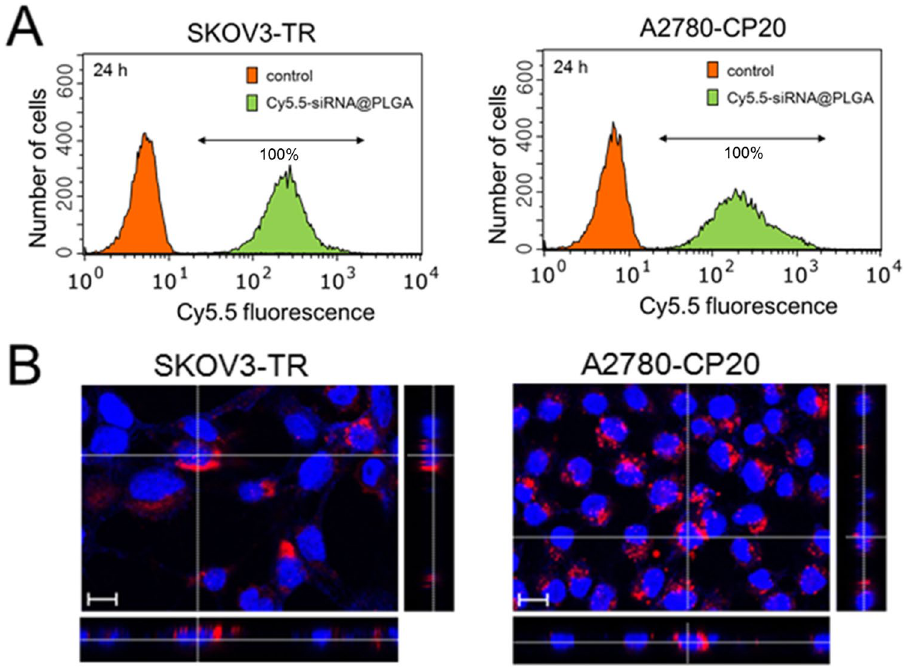
Figure 2. Efficient cellular internalization of siRNA@PLGA NPs on MDR ovarian cancer cells. ( A ) Flow cytometric histogram showing cellular internalization of the fluorescent siRNA@PLGA NPs on SKOV3-TR and A2780-CP20 cancer cells respectively. The resistance cell lines were treated with fluorescent Cy5.5-siRNA@ PLGA NPs, and 24 h later, sorted. A prefixed gate region was allowed only for Cy5.5 fluorescence. The untreated cells are indicated as a control. ( B ) Z-stack confocal microscopic images of SKOV3-TR and A2780-CP20 cancer cells treated with Cy5.5-labeled siRNA@PLGA NPs. Cy5.5-siRNA and DAPI dyes are represented by red and blue, respectively. Scale bar: 10 μ